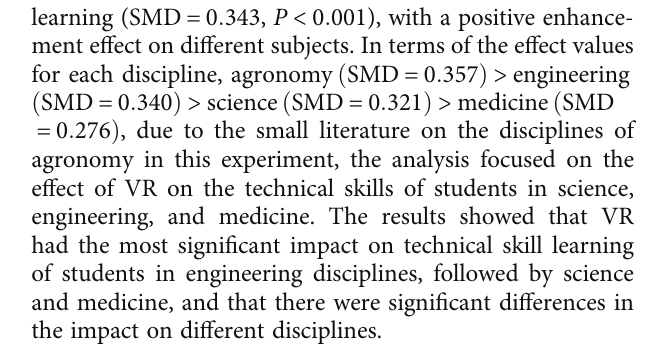
Table 4: E ff ects of di ff erent auxiliary methods.